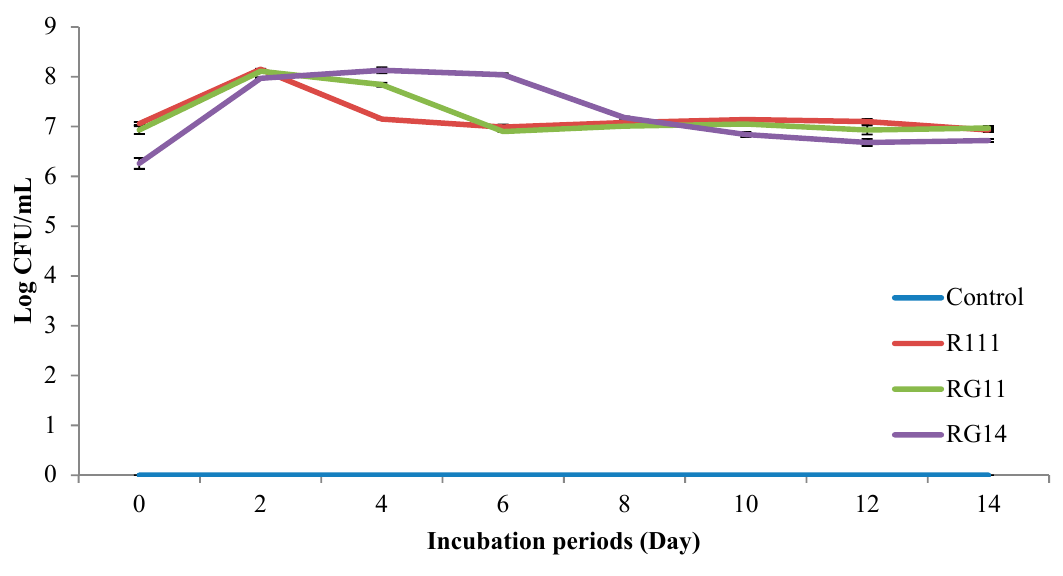
Figure 3. Lactic acid bacteria population of palm kernel cake extracts treated with Lactobacillus plantarum strains via solid state fermentation. Notes: RG14, L. plantarum RG14; RG11, L. plantarum RG11; R111, L. plantarum RI11; Control: untreated PKC extract. Error bar: standard error of mean (SEM), n = 3.